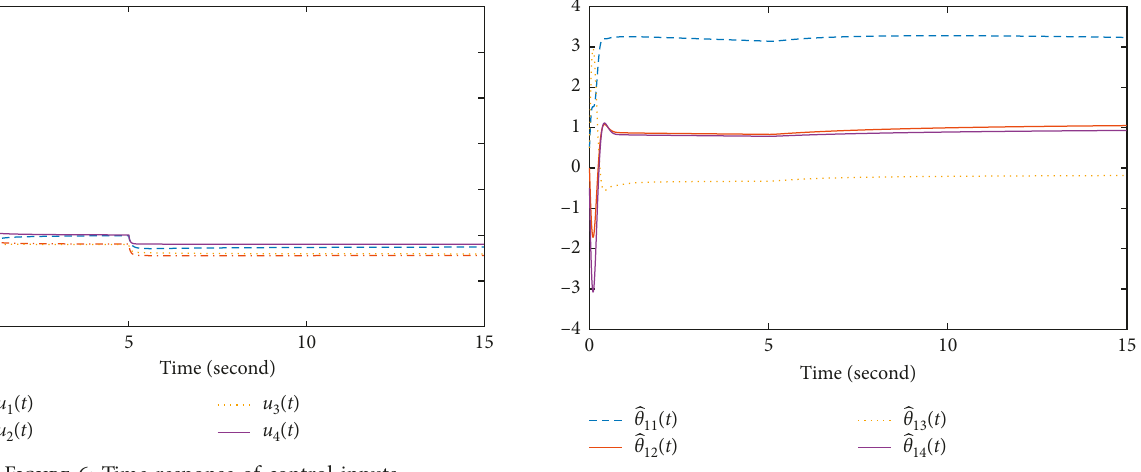
Figure 8: The estimation of θ